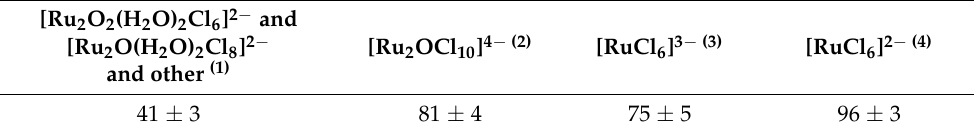
Table 4. Dependence of sorption degree from Ru chlorocomplex forms in different model solutions ( n = 3, p = 0.95).